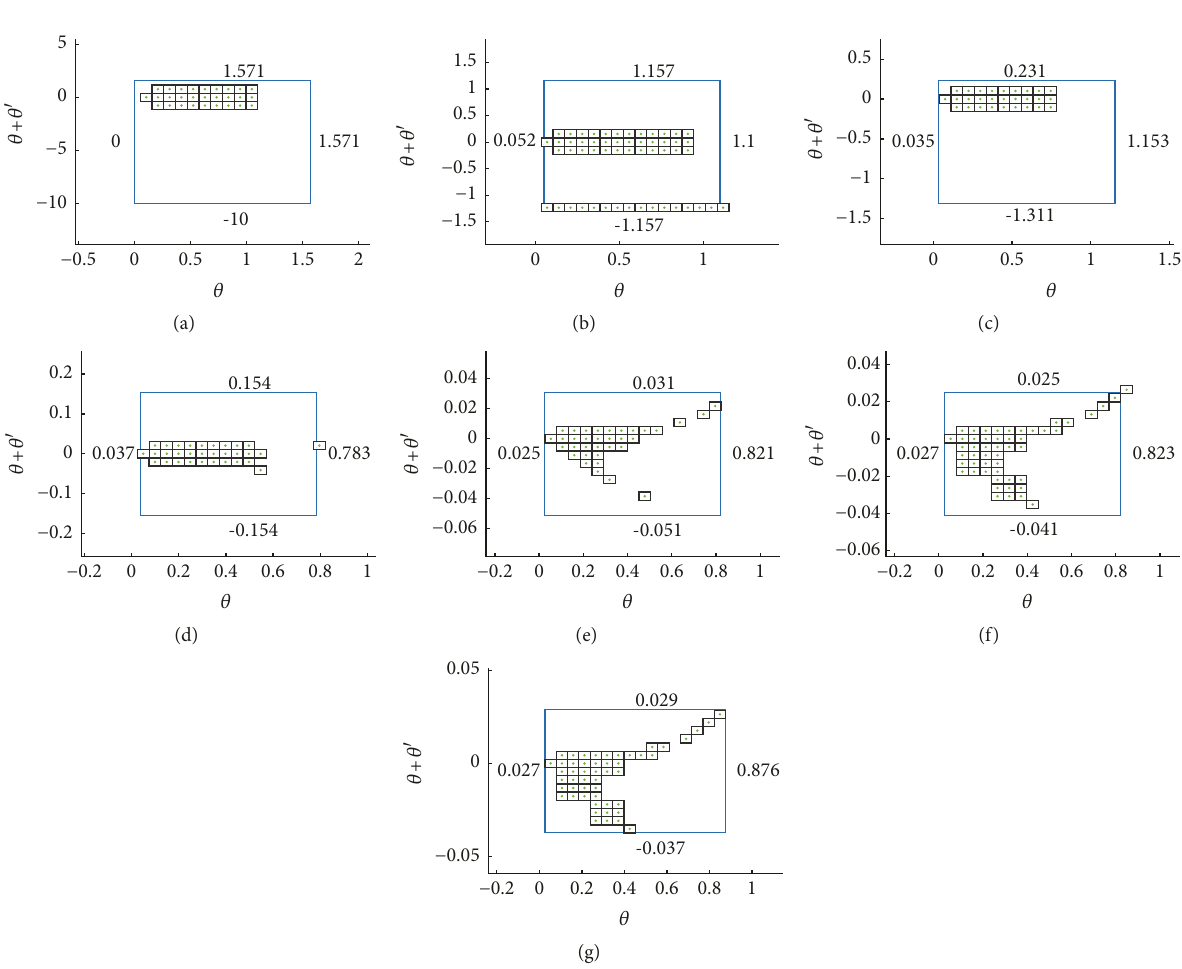
Figure 6: The processes of selecting the DOI of SPBW. (a) Initial DOI and DOC (b) DOI and DOC after the first iteration; (c) DOI and DOC after the second iteration; (d) DOI and DOC after the third iteration; (e) DOI and DOC after the fourth iteration; (f) DOI and DOC after the fifth iteration; (g) the formal